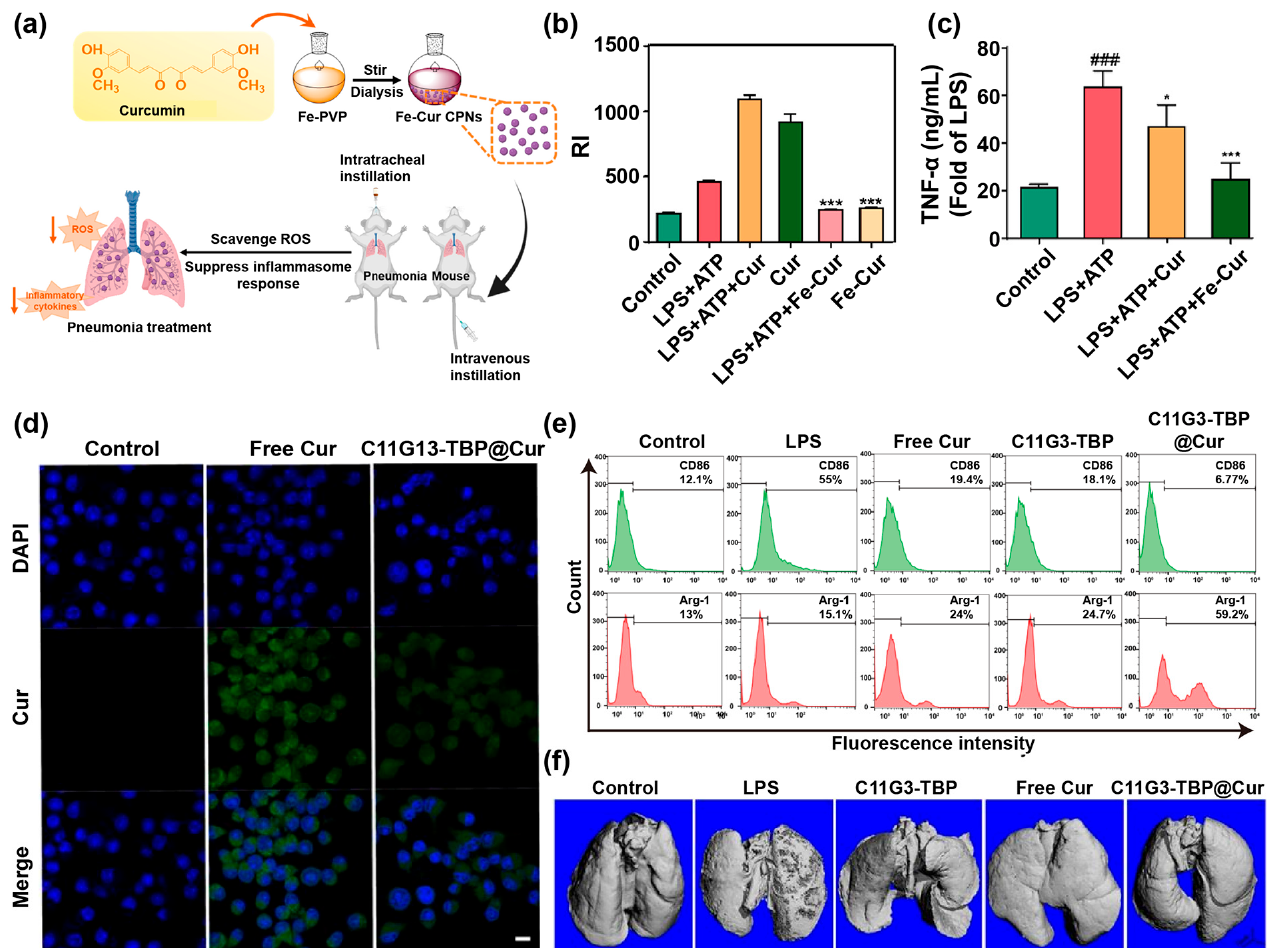
Figure 6. ( a ) Schematic illustration of Fe-Cur NP synthesis and its therapeutic treatment in acute lung injury. ( b ) Quantitative results of the fluorescence intensity of ROS in J774A.1 cells. ( c ) The content of TNF- α in J774A.1 cells treated with different NPs. The ### indicates p < 0.001 as compared with the control group, while the * indicates p < 0.05, and *** indicates p < 0.001 compared with the LPS + ATP group. Reproduced with permission [109], Copyright 2022, American Chemical Society. ( d ) CLSM images of LPS-activated MH-S cells treated with PBS, Cur, and C11G3-TBP@Cur for 4 h (Scale bar = 10 μ m). ( e ) Detection of CD86 and Arg-1 expression in MHS cells treated with different NPs by flow cytometry. ( f ) Micro-CT images of lung tissue in different treatment groups. Reproduced with permission [22], Copyright 2022,